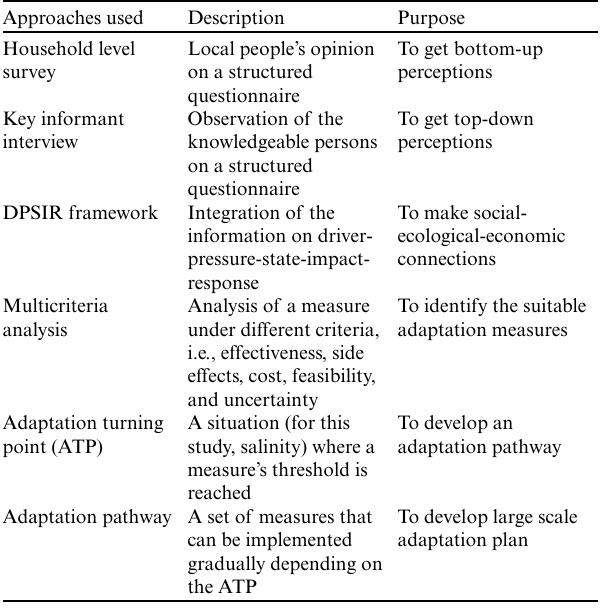
Table 1 . Approaches used in this study along with their specific